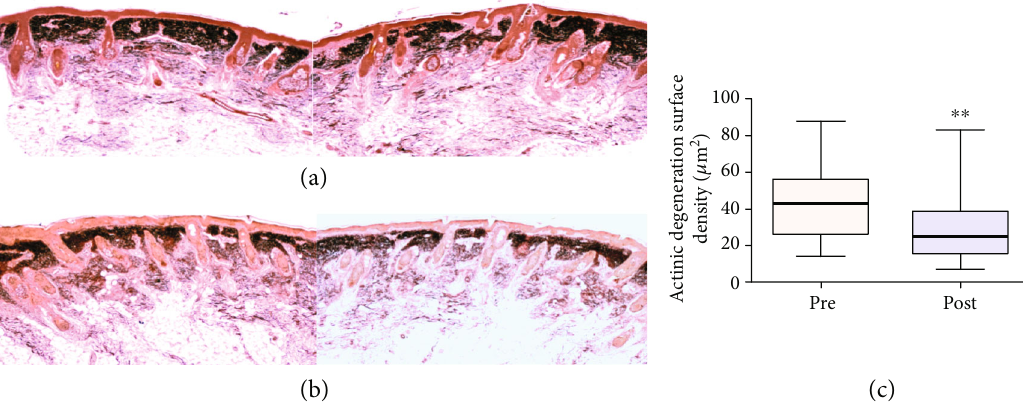
Figure 7: Photomicrographs representative of histological sections of biopsies before and after treatment with ADSCs. (a) Pretreatment biopsies showing intense actinic elastosis in the papillary and reticular dermis. (b) After treatment, a reduction in the elastotic mass in the dermis was observed. Stained: oxidized orcein. (c) Graph of the surface density of the reactive material for oxidized orcein in zone 2 reveals a signi fi cant reduction in elastosis ( p = 0 : 005